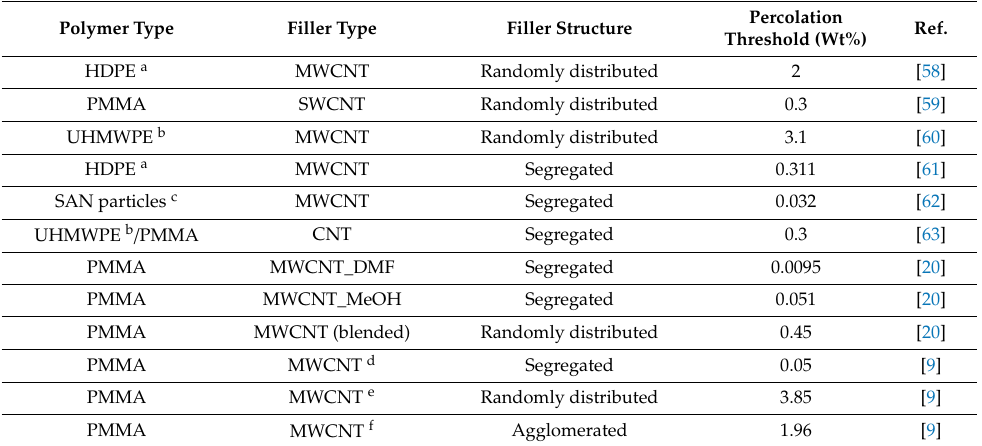
Table 1. Percolation threshold values from recent research on carbon nanotube (CNT)-polymer composites. Modified from [20].